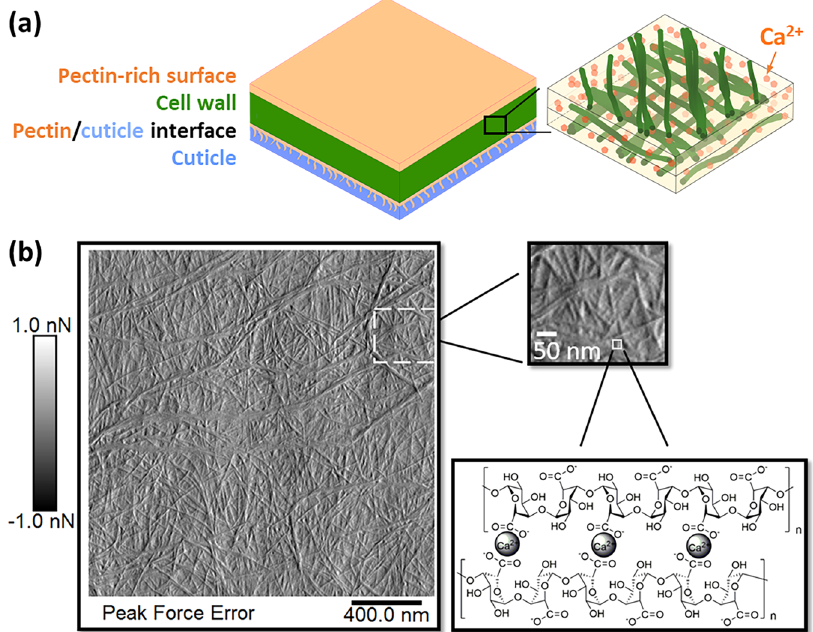
selected for this study because it is thinner than older (outer) scales.